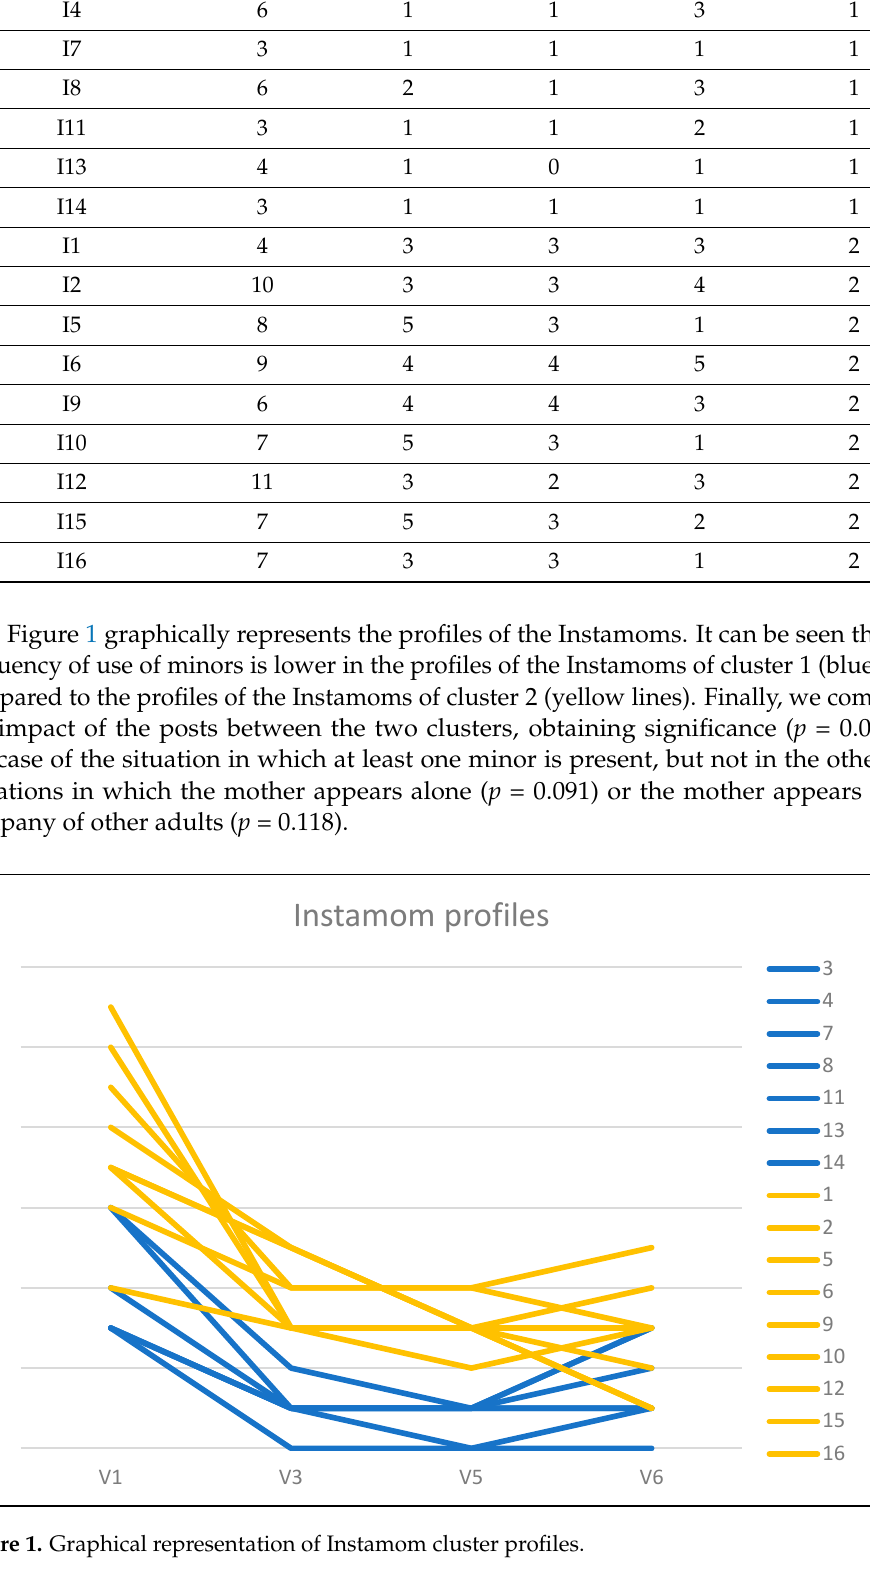
Figure 1. Graphical representation of Instamom cluster